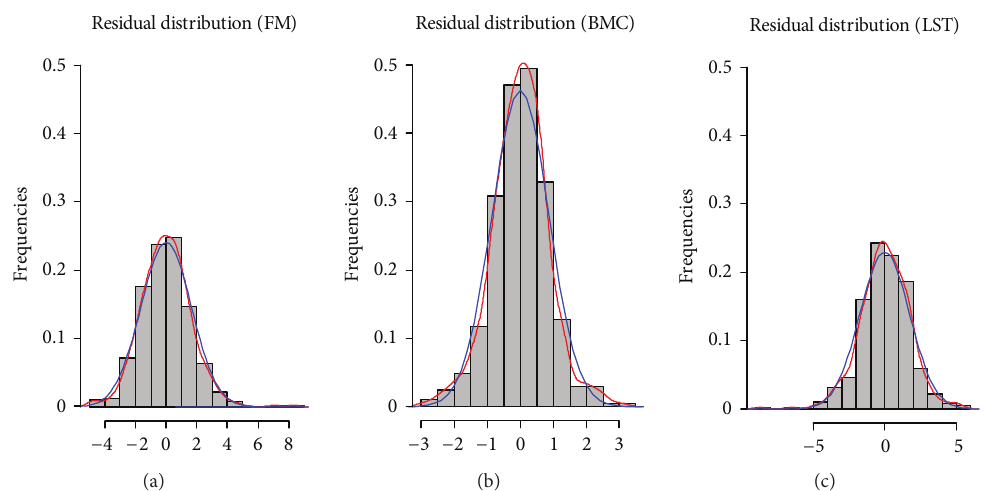
Figure 1: Multivariate distribution of residuals for fat mass (FM), bone mineral content (BMC), and lean soft tissue (LST).